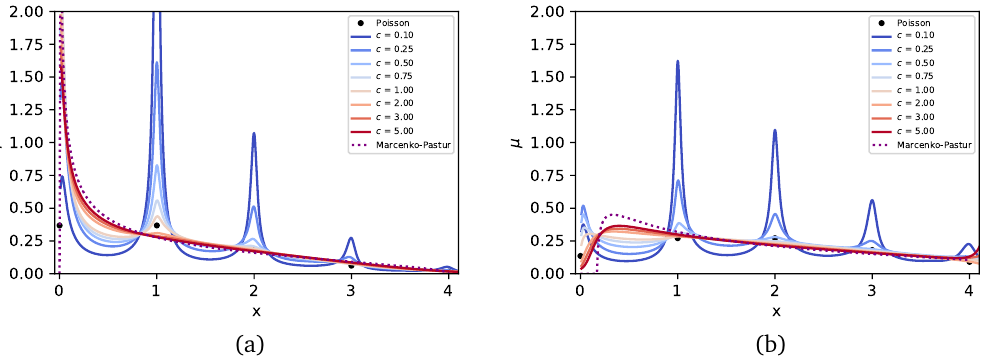
Figure 5: Plots of the numerical approximation of the limiting distribution of the Poisson limit theorem with parameters a = 1 , λ = 1 in ( a ), λ = 2 in ( b ), for different values of c . compared to the classical (Poisson) and free (Marˇcenko-Pastur) limiting